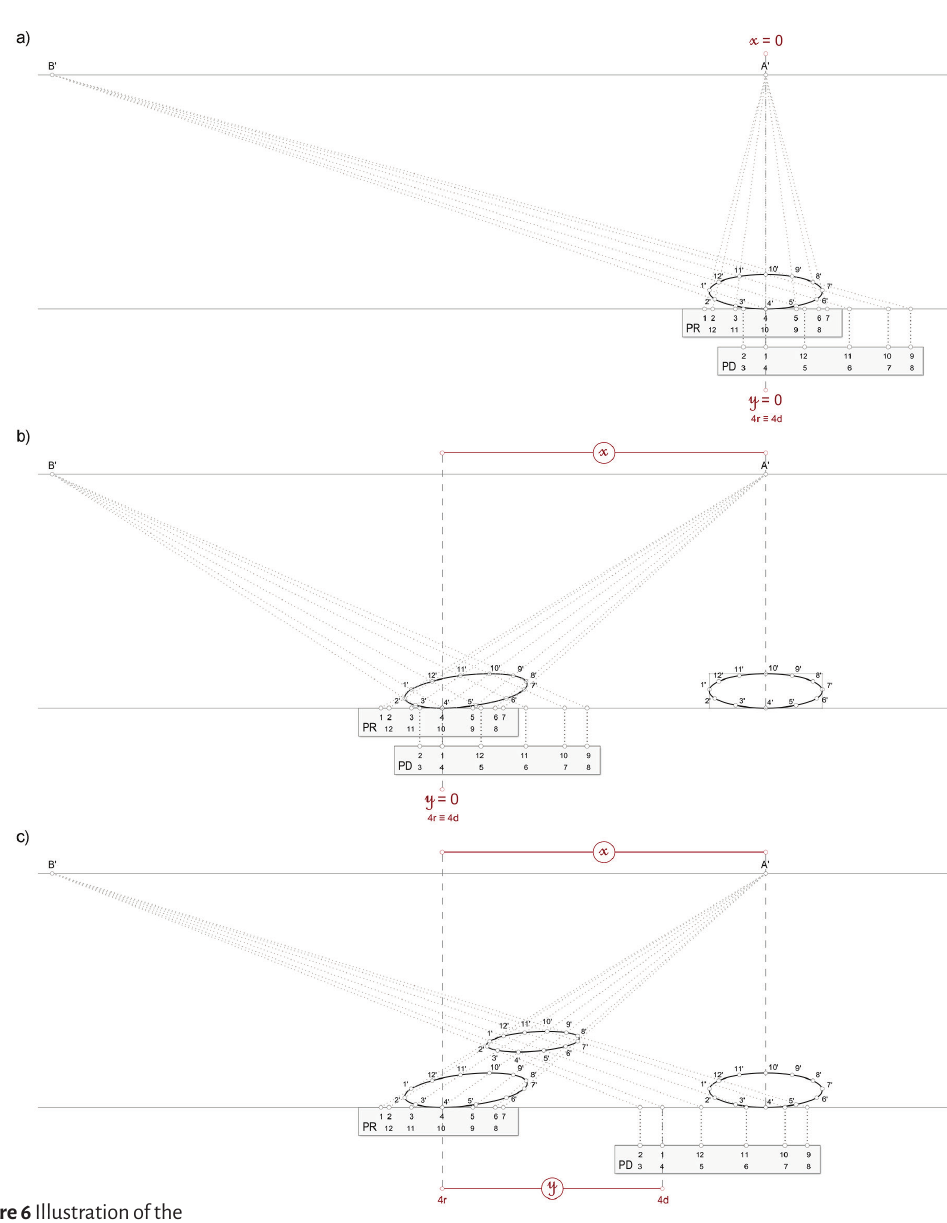
Figure 6 Illustration of the process of construction of the perspective with “sagme” as described by Jacopo Barozzi da Vignola. Author’s